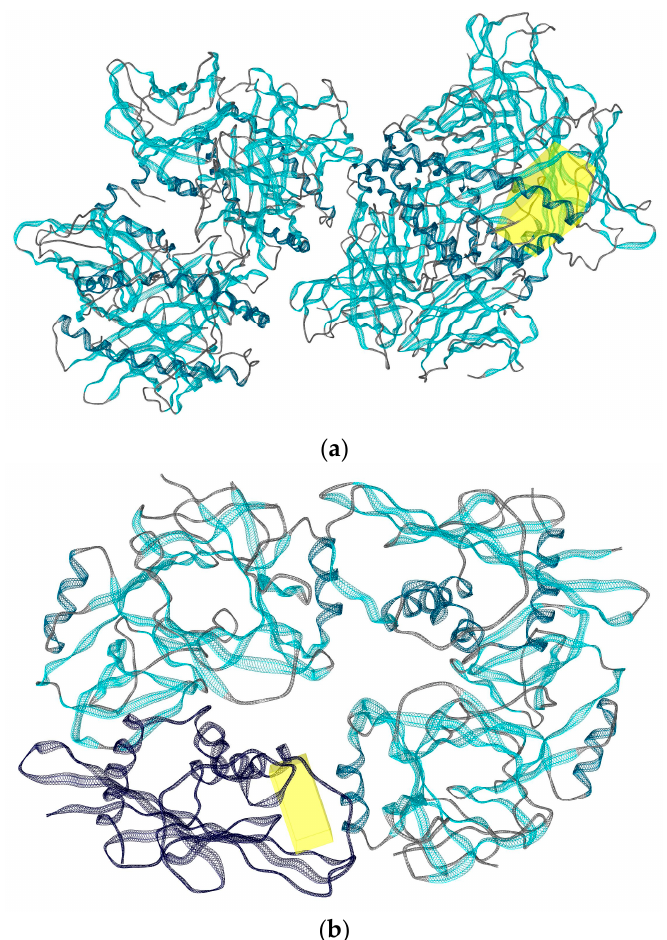
Figure 2. Two cowpox proteins were used in this study: ( a ) the binding site (yellow) of cowpox CPXV203 protein; ( b ) the binding site (yellow) of cowpox OMCP protein.